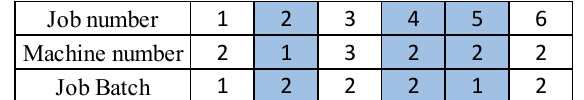
Fig. 5 A new particle created after conversion of random numbers to integer